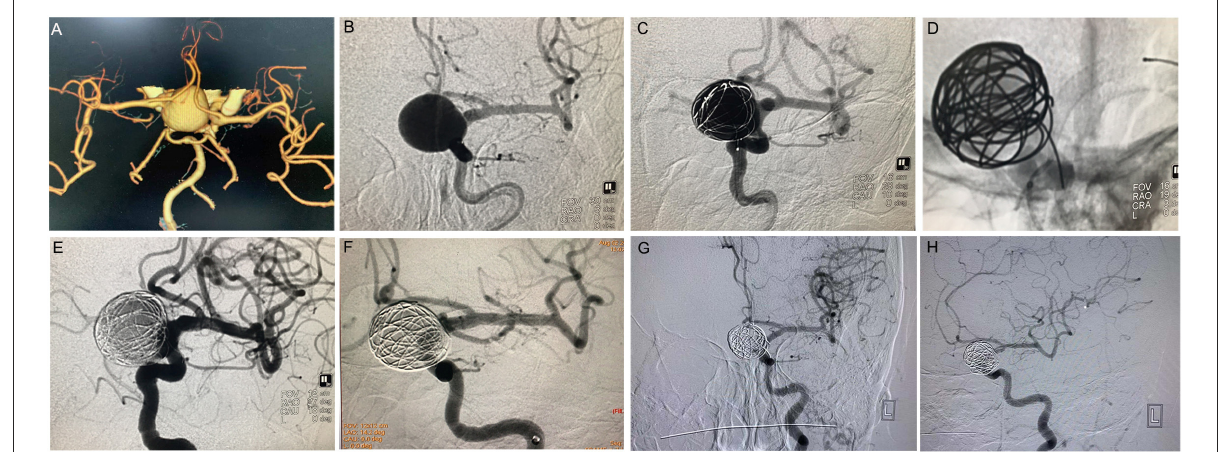
FIGURE1 Pipeline TM treatment of giant wide-necked aneurysm in the clinoid segment of the internal carotid artery. (A) CTA results show a giant wide-necked aneurysm in the clinoid segment of the left internal carotid artery; (B) working angle measurement indicates an aneurysm size of approximately 19.2mm × 22.7mm and an aneurysm neck of 15mm; (C) first, a microcatheter is used to release the coil, and the coil is formed into a basket to support Pipeline TM release; (D) release of the 4.0 × 25 Pipeline TM ; (E) the micro-guide wire is used to massage the stent to make the stent fit the wall completely; (F) 30min later, the aneurysm is observed to be completely unremarkable on angiographic re-examination; and (G,H) 6 months after the procedure, DSA imaging re-examination shows complete healing of the